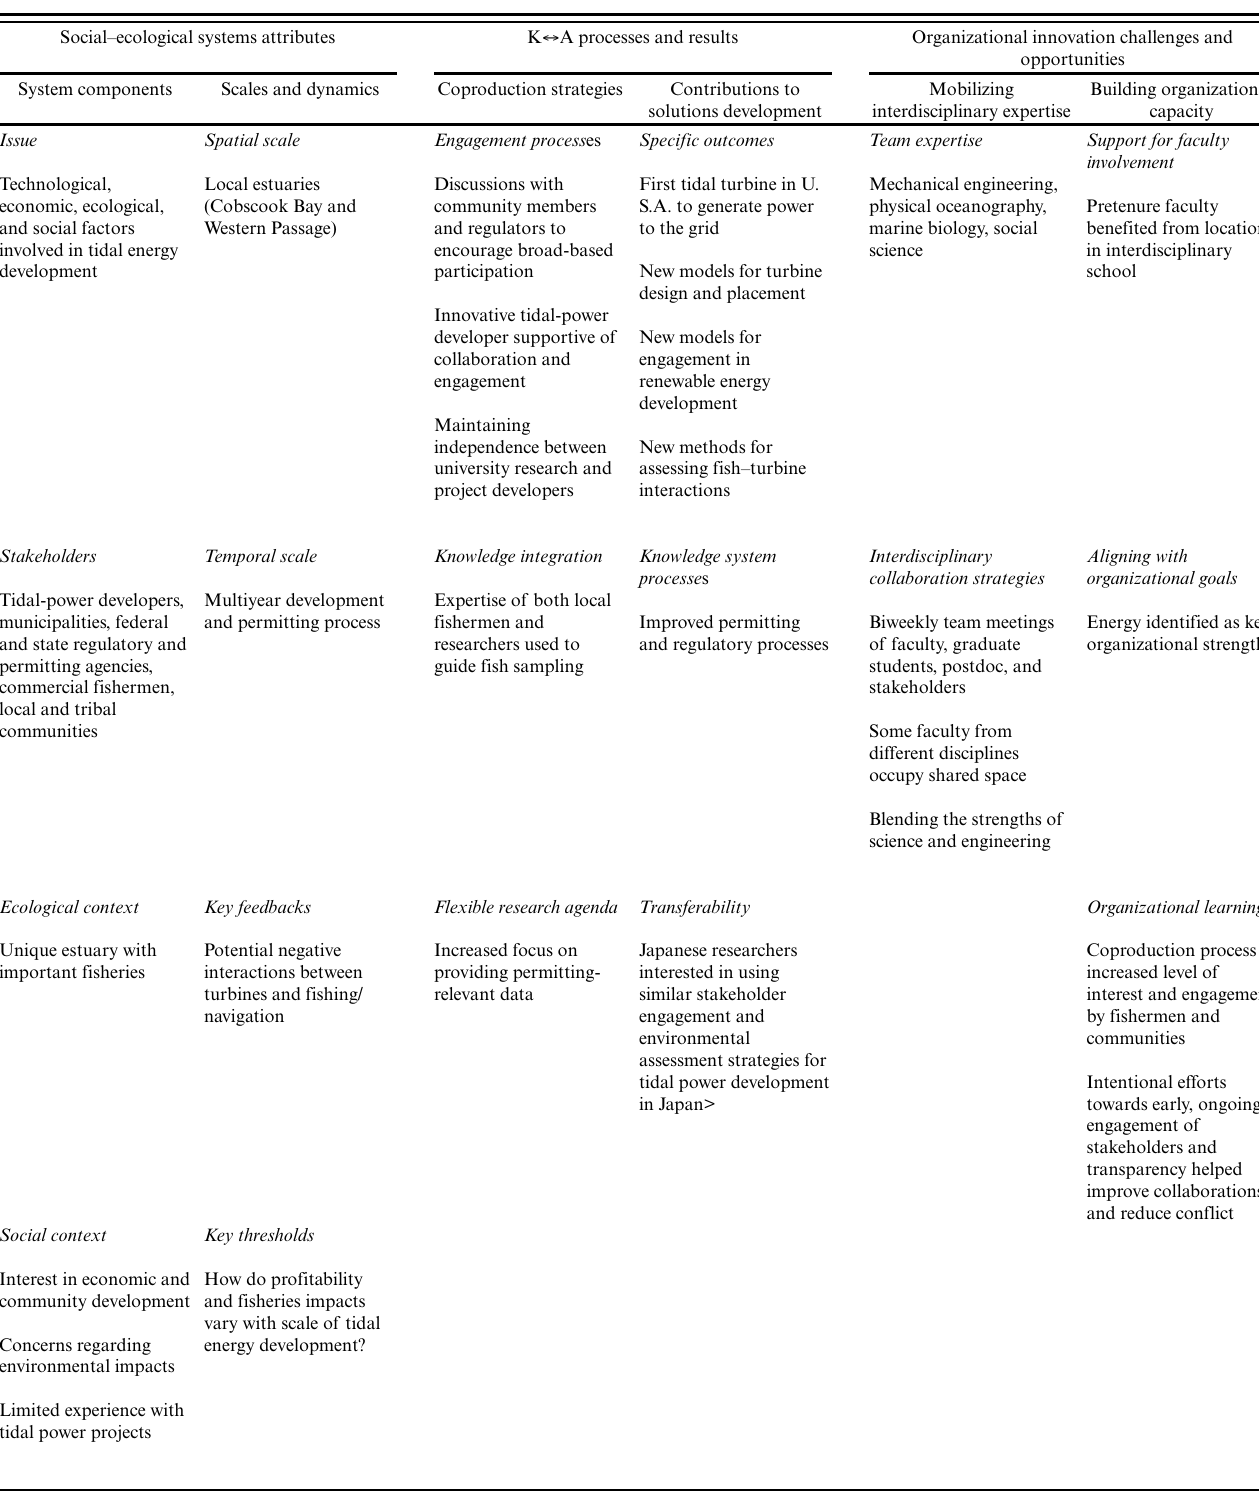
Table 1 . Major characteristics of three solutions-focused research projects: tidal energy. Social–ecological systems